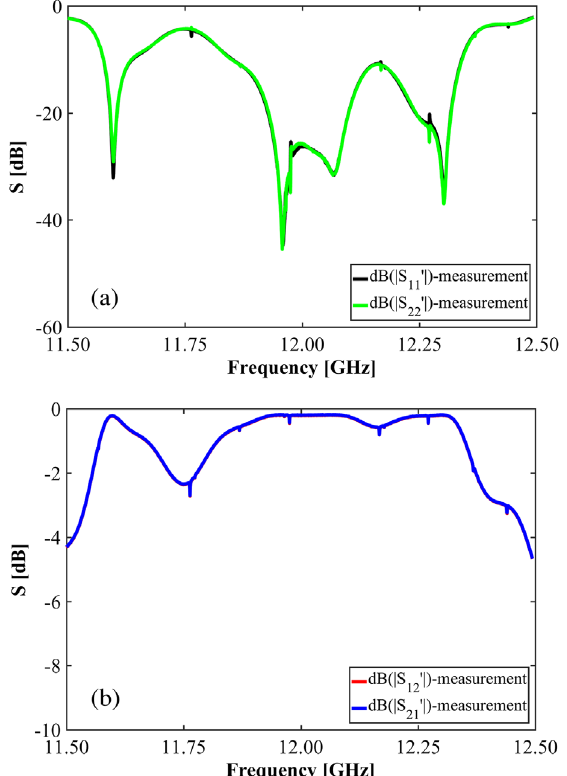
FIG. 22. Comparisons between measured (a) S 0 11 and S 0 22 , (b) S 0 12 and S 0 21 for two end-part prototypes connected with an aluminum waveguide and two power splitters.